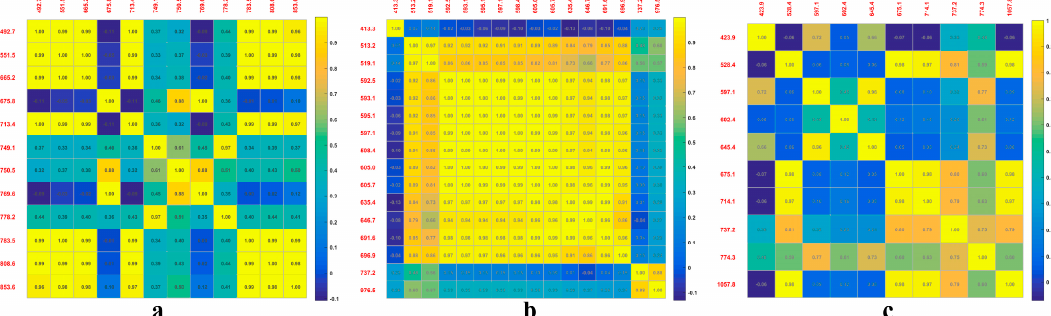
Figure 7. Wavelength correlation for three-dimensional reduction methods: ( a ) PCA; ( b ) RF; ( c ) SPA.